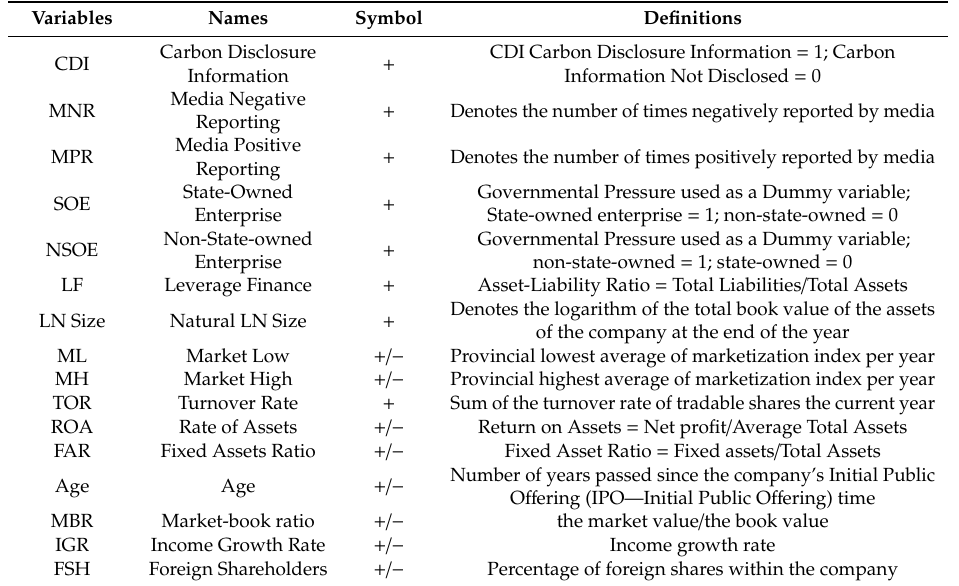
Table 1. Definitions of